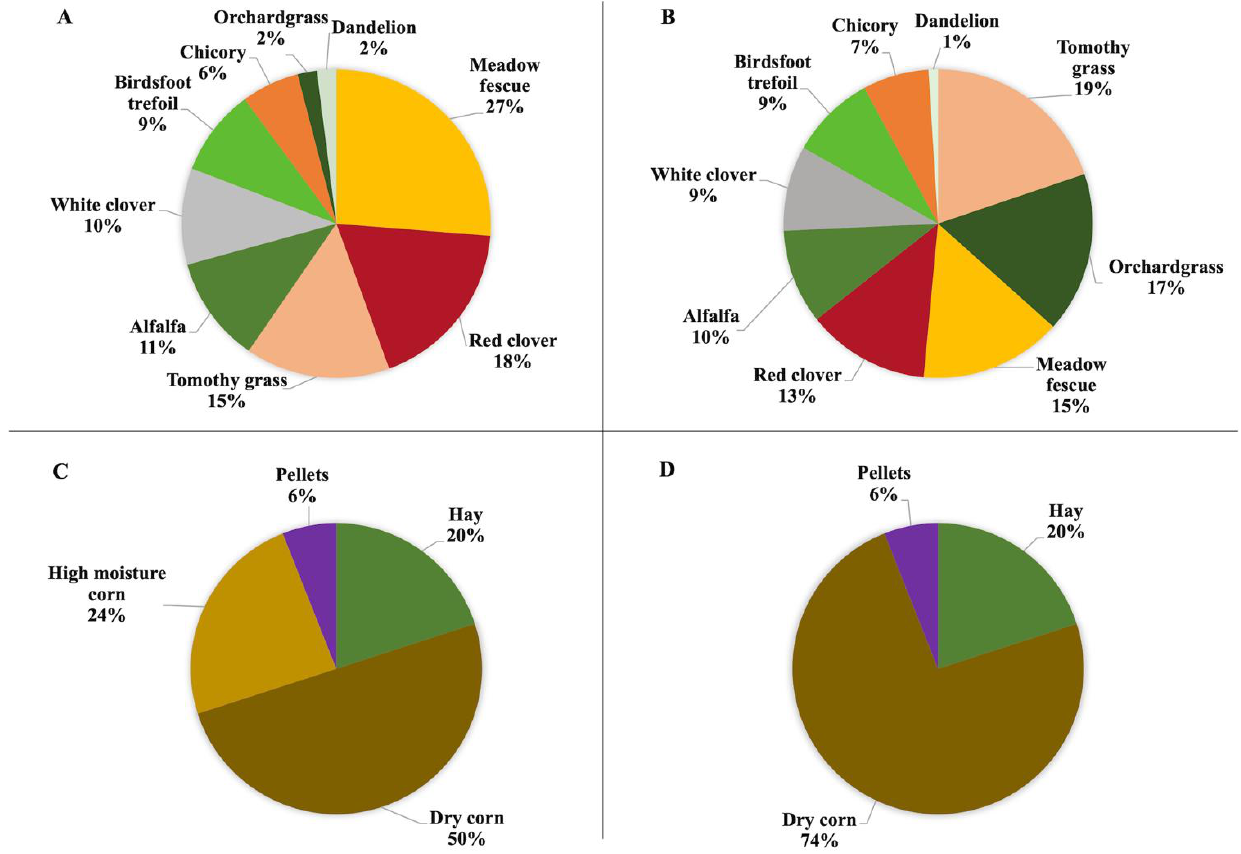
Figure 1. Botanical composition of the diets for 2019 and 2020. ( A ) 2019 GRASS, ( B ) 2020 GRASS, ( C ) 2019 GRAIN, ( D ) 2020 GRAIN. GRASS: complex pasture mixture; GRAIN: conventional grain diet (pellets contained 36% crude protein, hay was made of orchard grass).